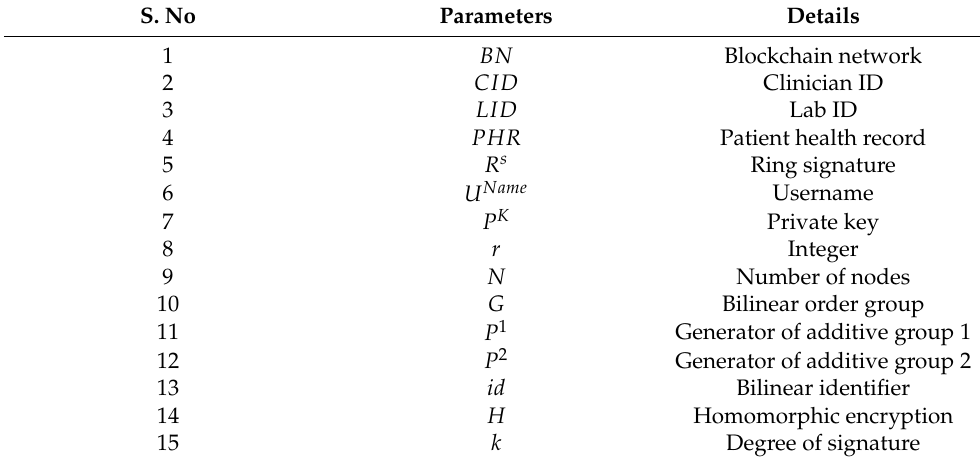
Table 1. List of parameters for our proposed algorithms.